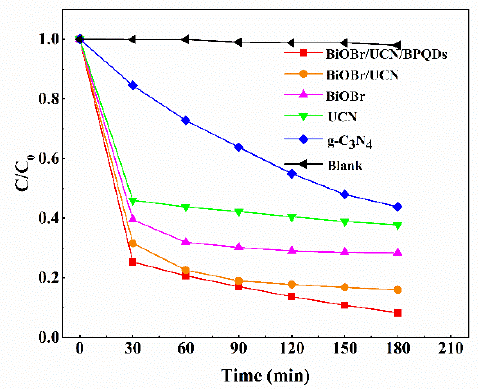
Figure 8. Degradation of tetracycline by catalyst under visible light.